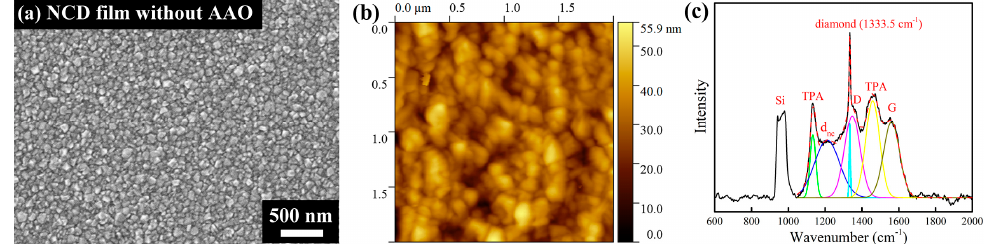
Figure 5. Characterization of the nanocrystalline diamond film grown on a flat Si wafer without AAO membrane. ( a ) SEM image, ( b ) AFM topographic image (2 × 2 μ m 2 ) and ( c ) Raman spectrum with peak deconvolution.